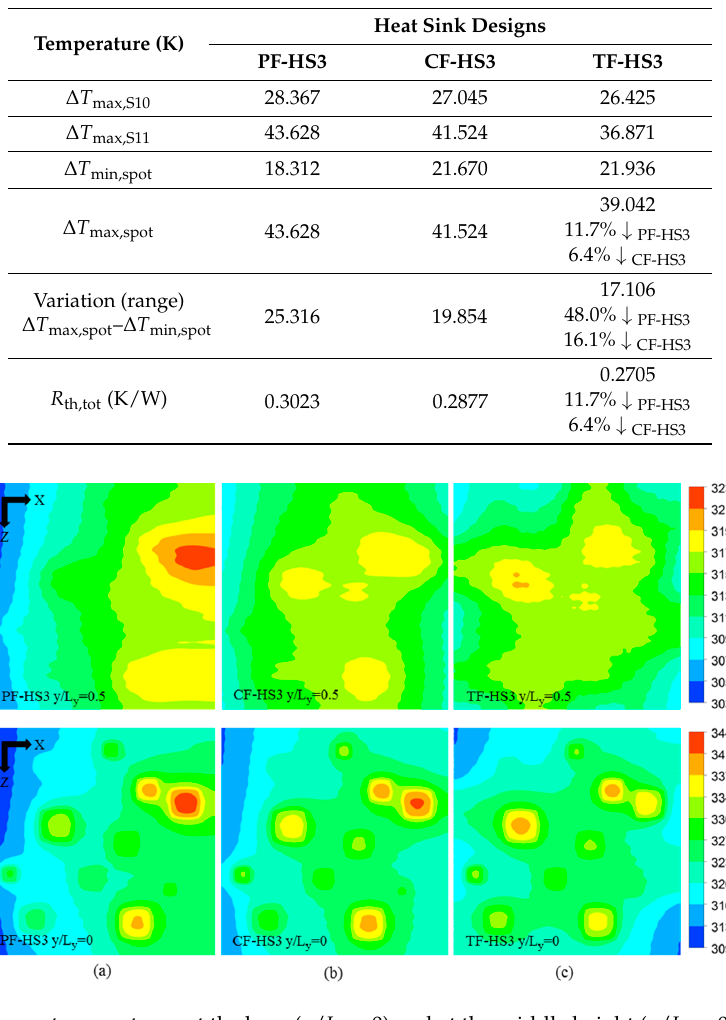
Figure 11. Temperature contours at the base ( y / L y = 0) and at the middle height ( y / L y = 0.5) of the heat sinks with the hotspot scheme HS3 at the total flow rate of 0.01 kg/s: ( a ) PF-HS3; ( b ) CF-HS3; and ( c ) TF-HS3.